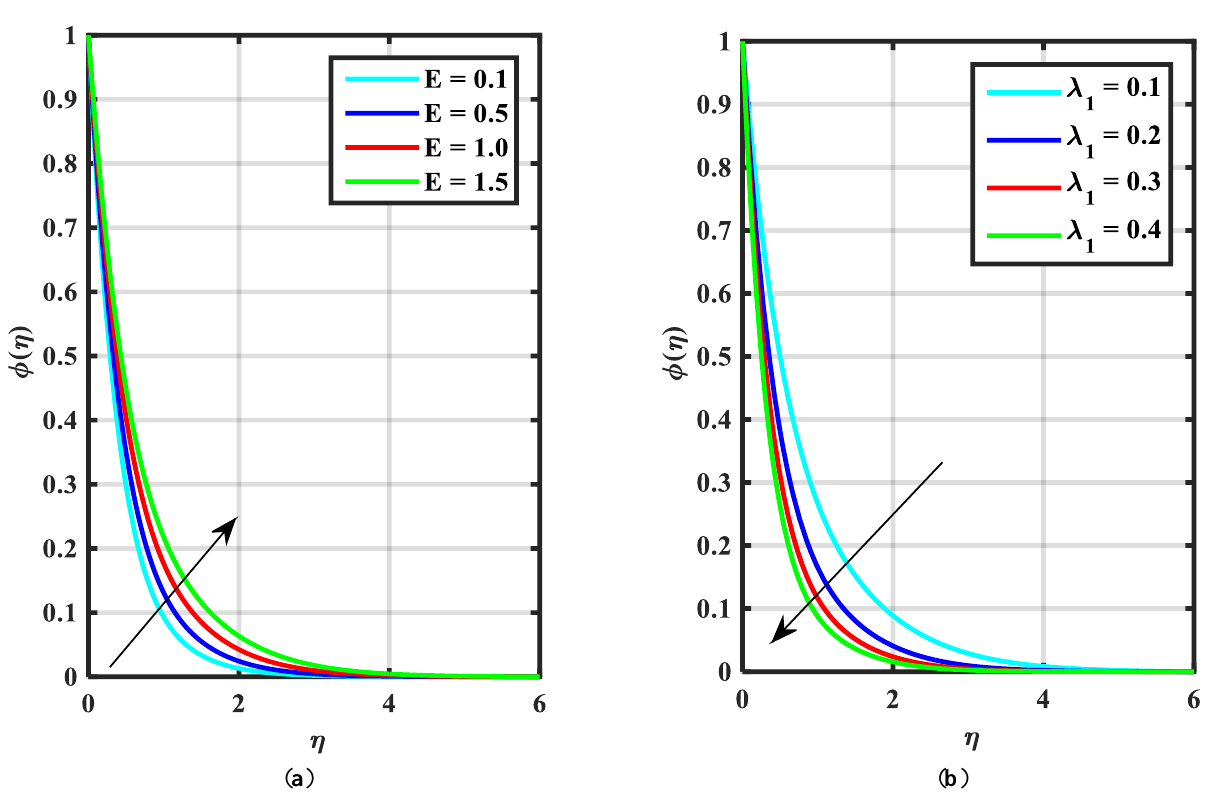
Figure 6. ( a , b ) Influence of φ ( η ) over activation energy E and chemical reaction constant λ 1 .